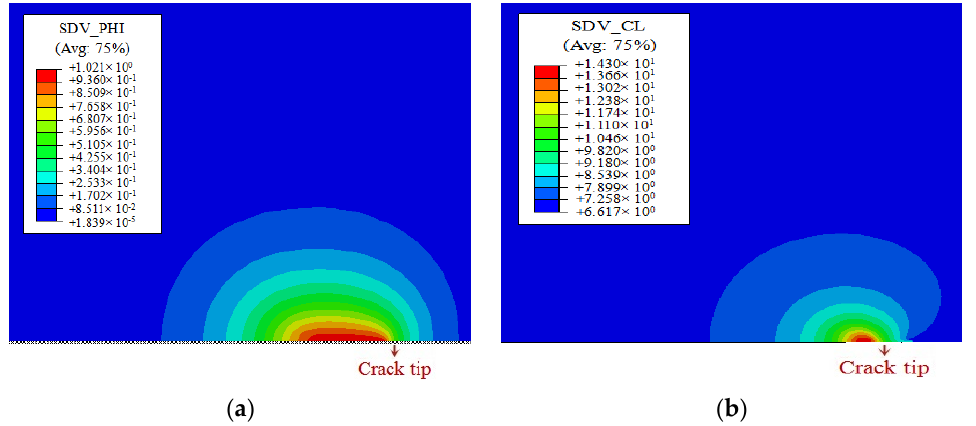
Figure 10. ( a ) Distributions of crack phase-field value and ( b ) hydrogen concentration at crack tip before the onset of crack initiation for C 0 = 7.0 ppm.